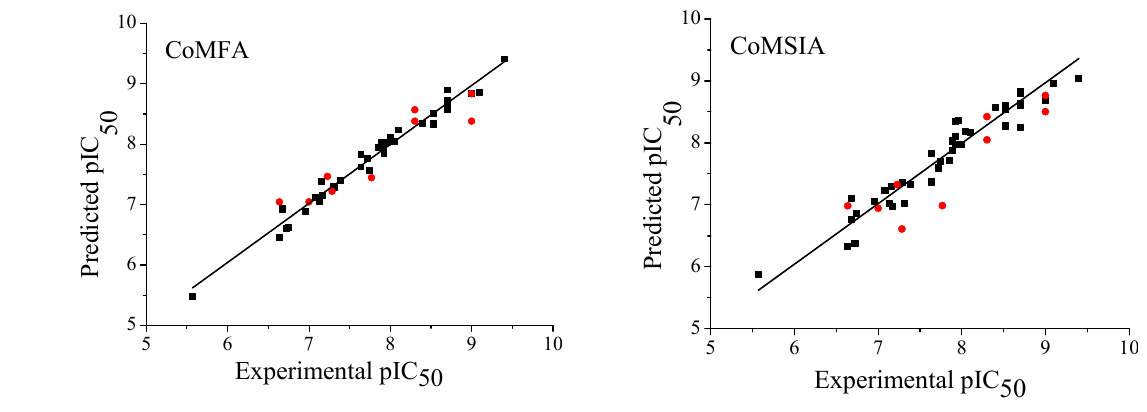
Figure 1. Graphs of the experimental versus predicted pIC test ( ● ) compounds from the CoMFA and CoMSIA models.